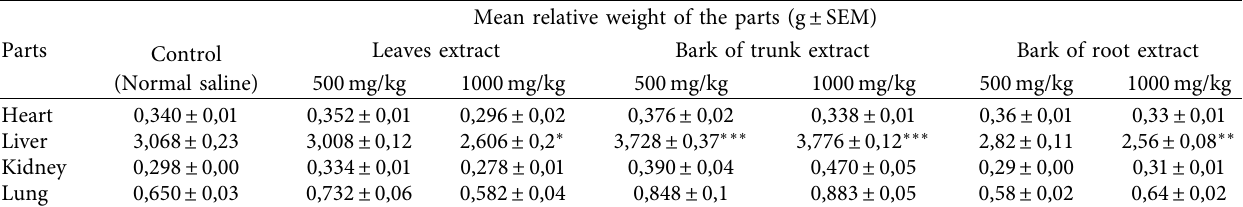
Table 3: Mean organ weight of rats after 28-day treatment with hydroethanolic leaf, bark of trunk, and bark of root of P. santalinoides . Parts